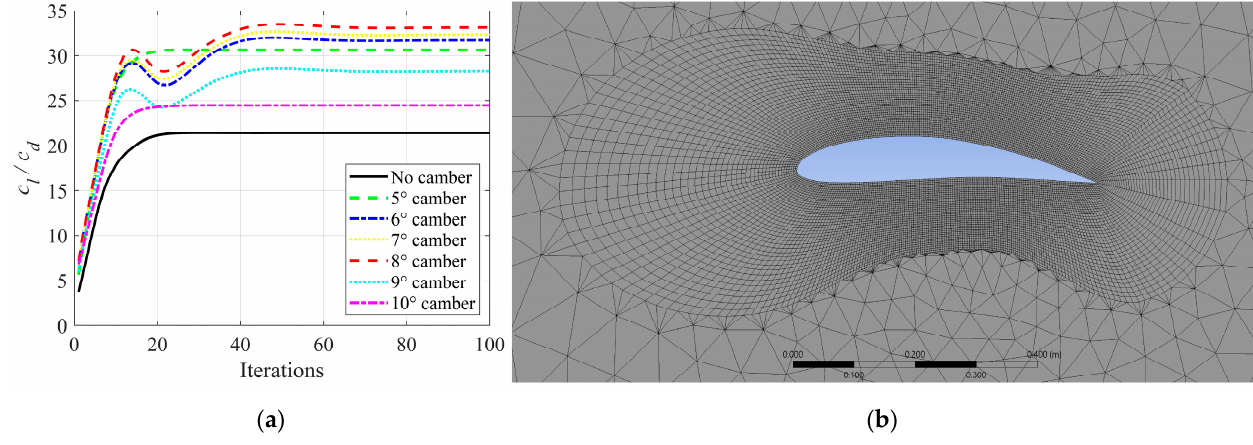
Figure 16. ( a ) Convergence plot of NACA 4415’s c l / c d at various camber angles; ( b ) Local mesh around NACA 4415 (8° camber).